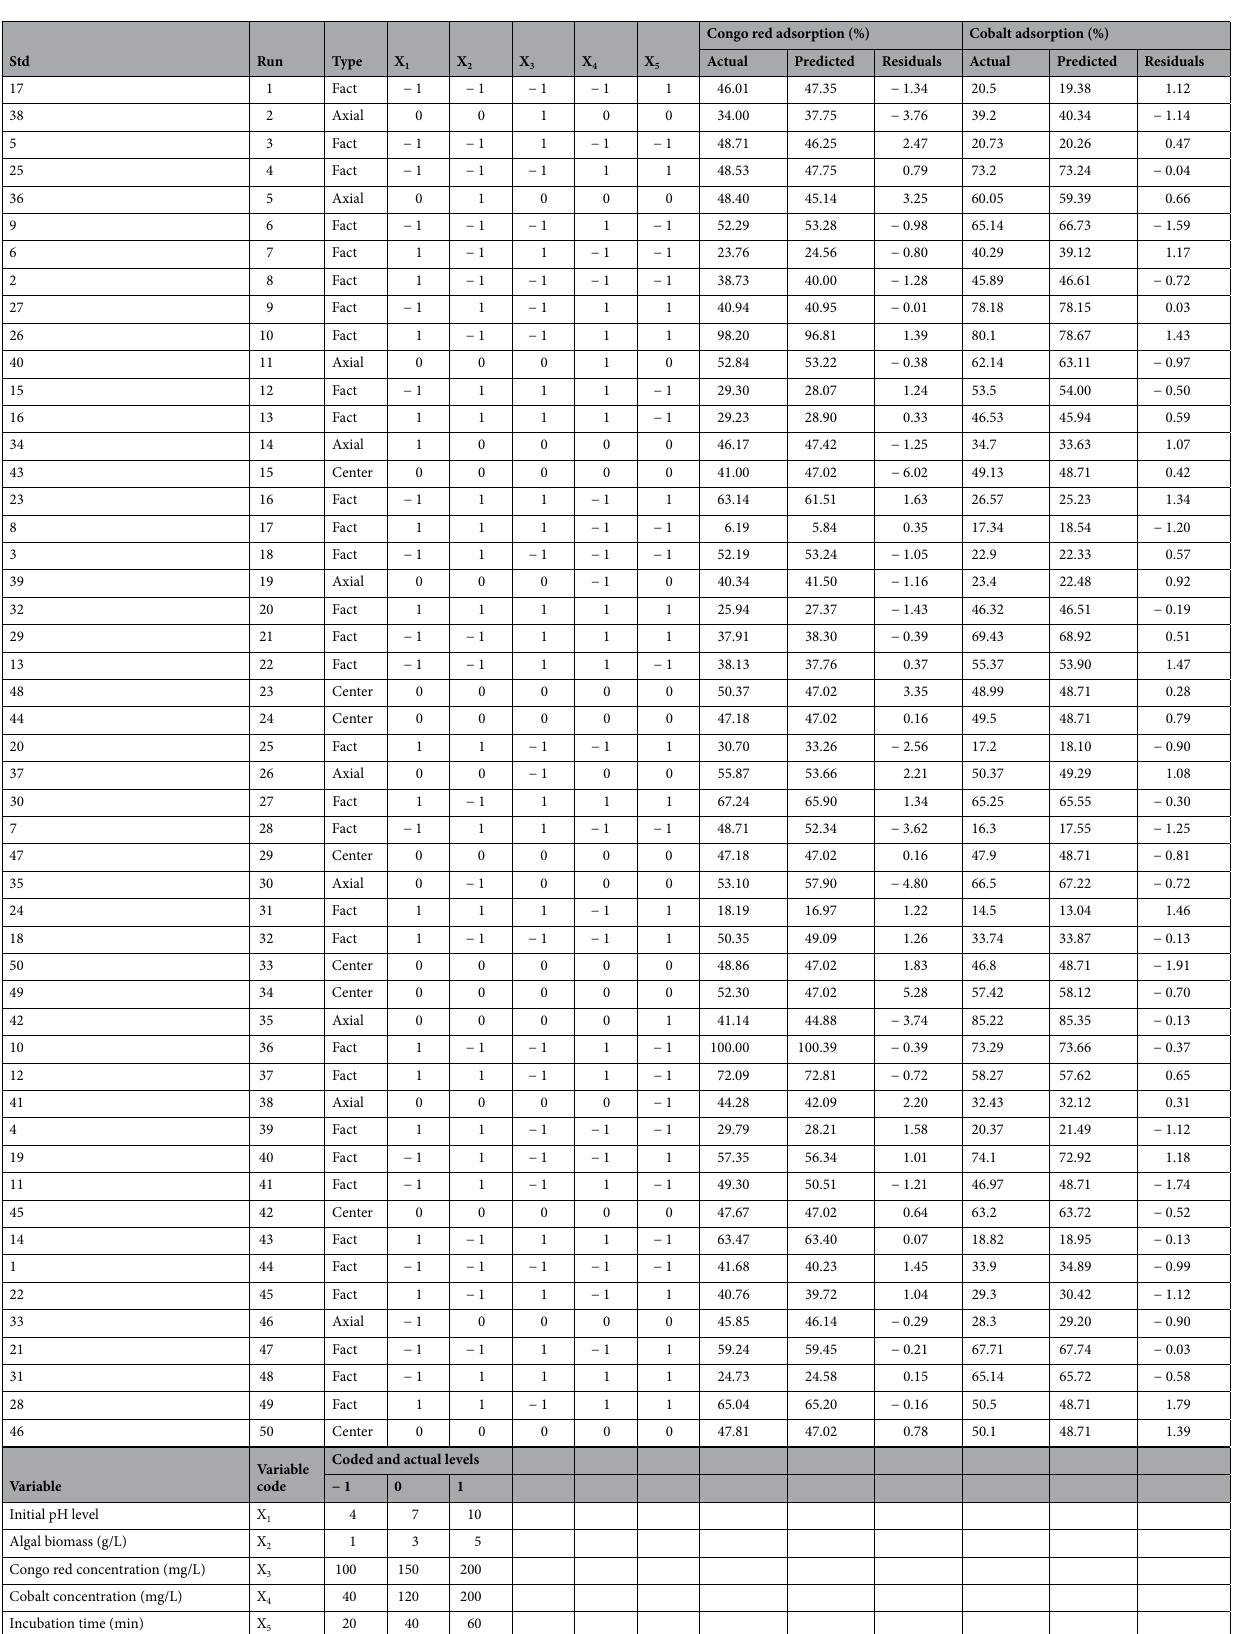
Table 1. Mean of experimental and predicted values of simultaneous biosorption of Congo red and cobalt by E. intestinalis using FCCCD